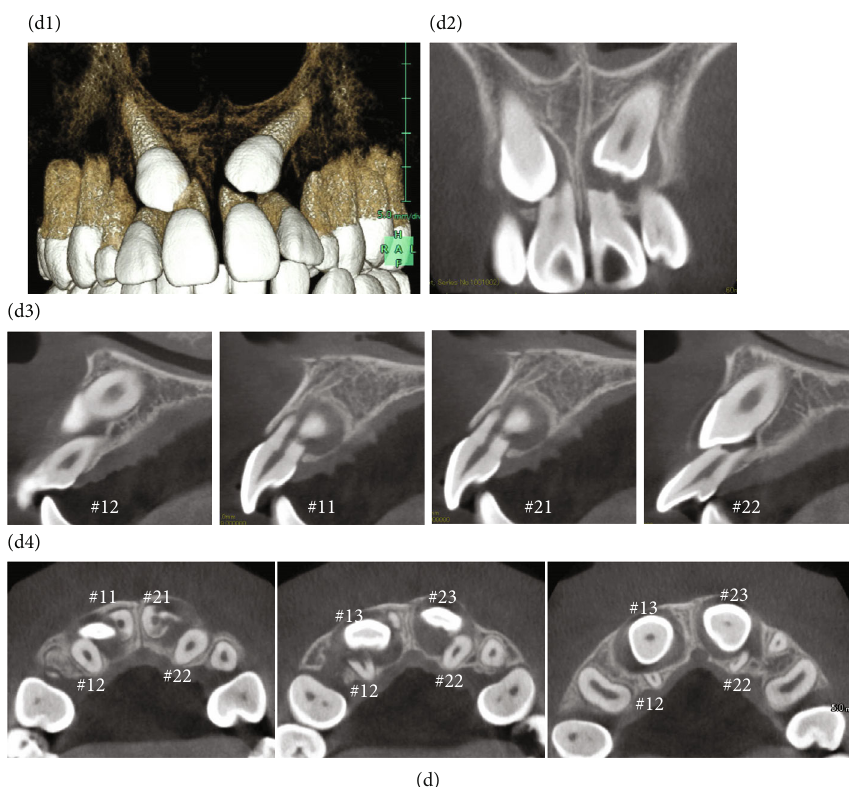
Figure 3: Pretreatment panoramic radiograph and cone-beam computed tomography (CBCT) images. (a) The impacted bilateral canines were mesially inclined. (b) The angle of inclination to the maxillary dental midline was 33 ° on the right side ( α ) and 43 ° on the left side ( β ). (c) According to Ericson and Kurol ’ s classi fi cation, tooth 13 had grade 4 impaction and tooth 23 had grade 5 impaction. (d) Both canines were located on the buccal side and the roots of the four incisors were resorbed (D1; three dimensional CBCT image, D-2; coronal view, D-3; sagittal view, D-4; axial view).